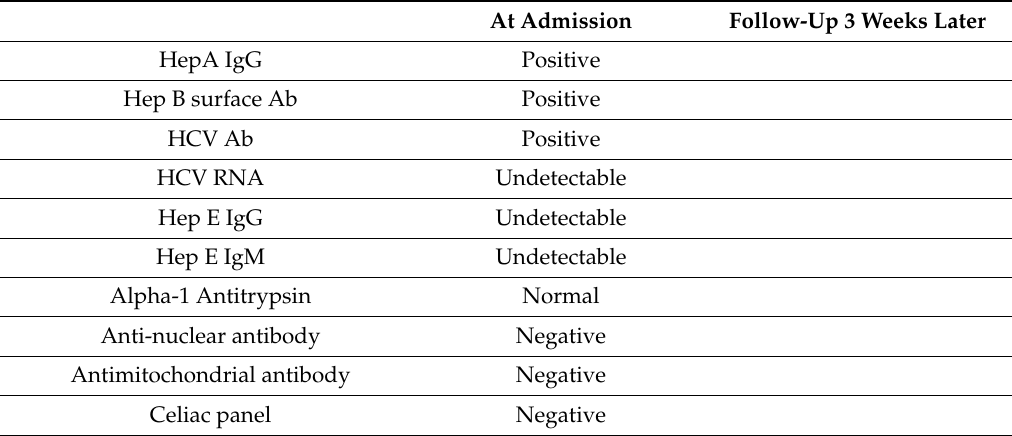
Table 1. Demonstration of the laboratory parameter upon